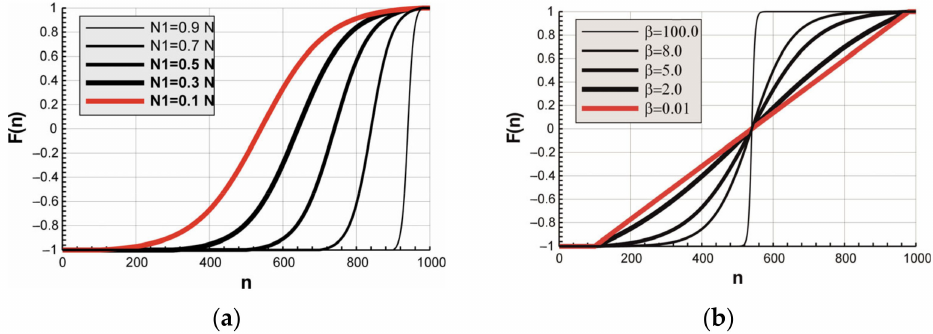
Figure 1. ( a ) Evolution of function F ( n ) based on increasing N 1 , N 2 fixed. ( b ) Function F ( n ) for selected values of β